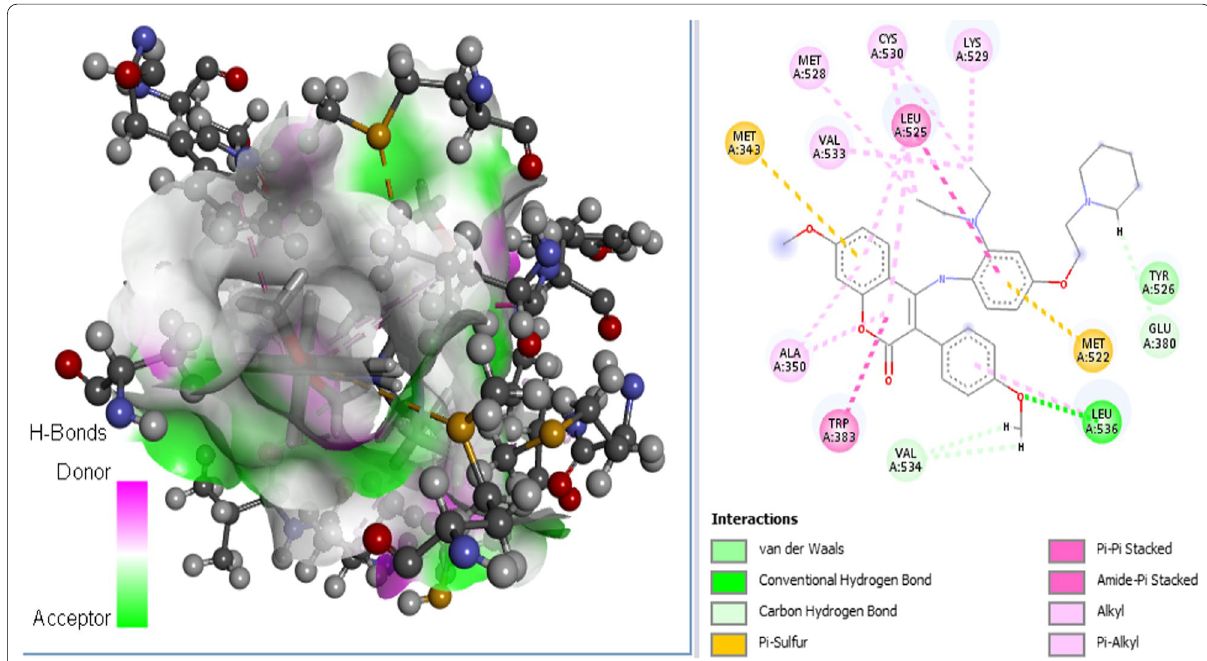
Fig. 12 3D and 2D interactions of designed compound 8 with the active site of the ER + receptor